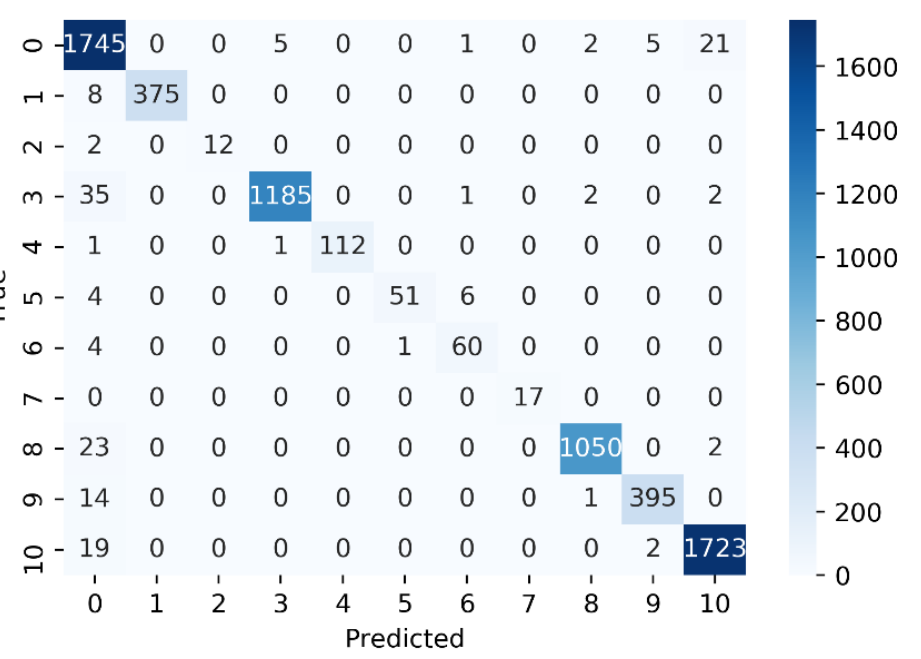
Figure 5. Confusion matrix (m) representing SVM classification performance on test set constructed with ECFP6 feature. The element m(i, j) is the number of times an observation of the ith true class was predicted to be of the jth class. Each colored cell of the confusion matrix chart corresponds to one element of the confusion matrix. Drug-like molecules, CB1, FFA2, mAchR M1, S1P3, GLP1-R, GCGR, PTHrP, mGlu2, mGlu4, and mGlu5 were labeled as 0 to 10, respectively.